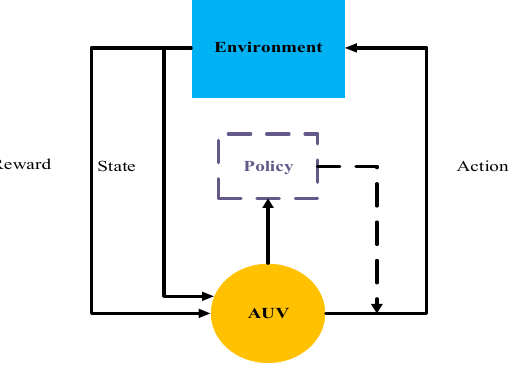
Figure 4. Reinforcement learning (RL) mechanism.